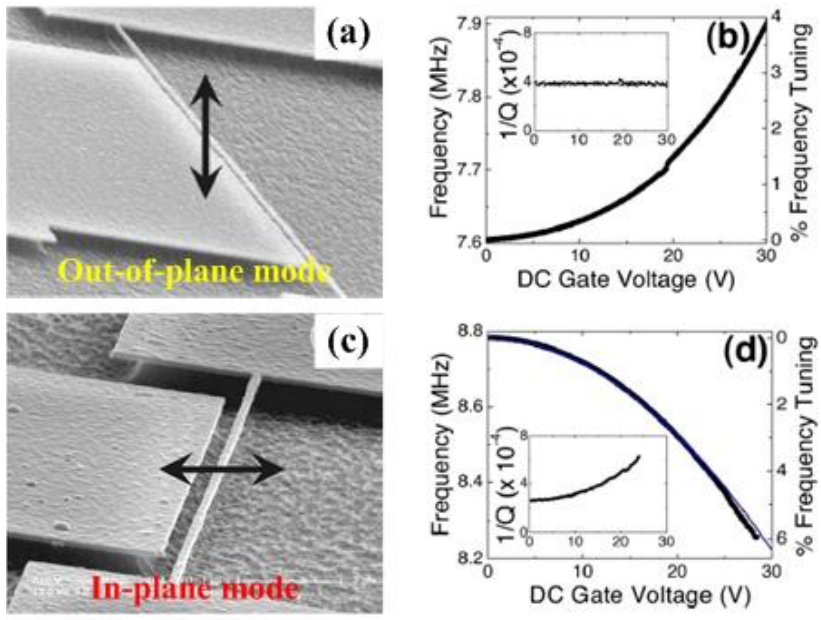
Figure 24. Electrostatic tuning setup and measurement reported by Kozinsky et al . [15]. ( a ) The beam’s vibration out-of-plane with the gate; ( b ) Elastic tuning of resonant frequency upward; ( c ) The beam’s vibration in-plane of the gate; ( d ) Capacitive tuning of resonant frequency downward. Reused with permission from [15], Copyright 2006, American Institute of